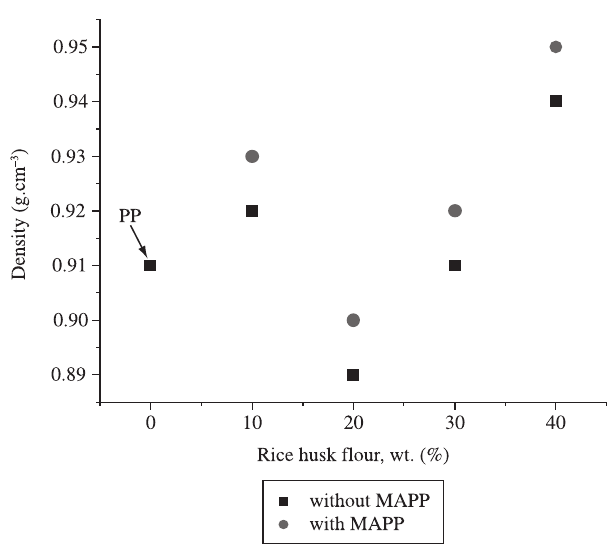
Figure 6. Density measurements of the